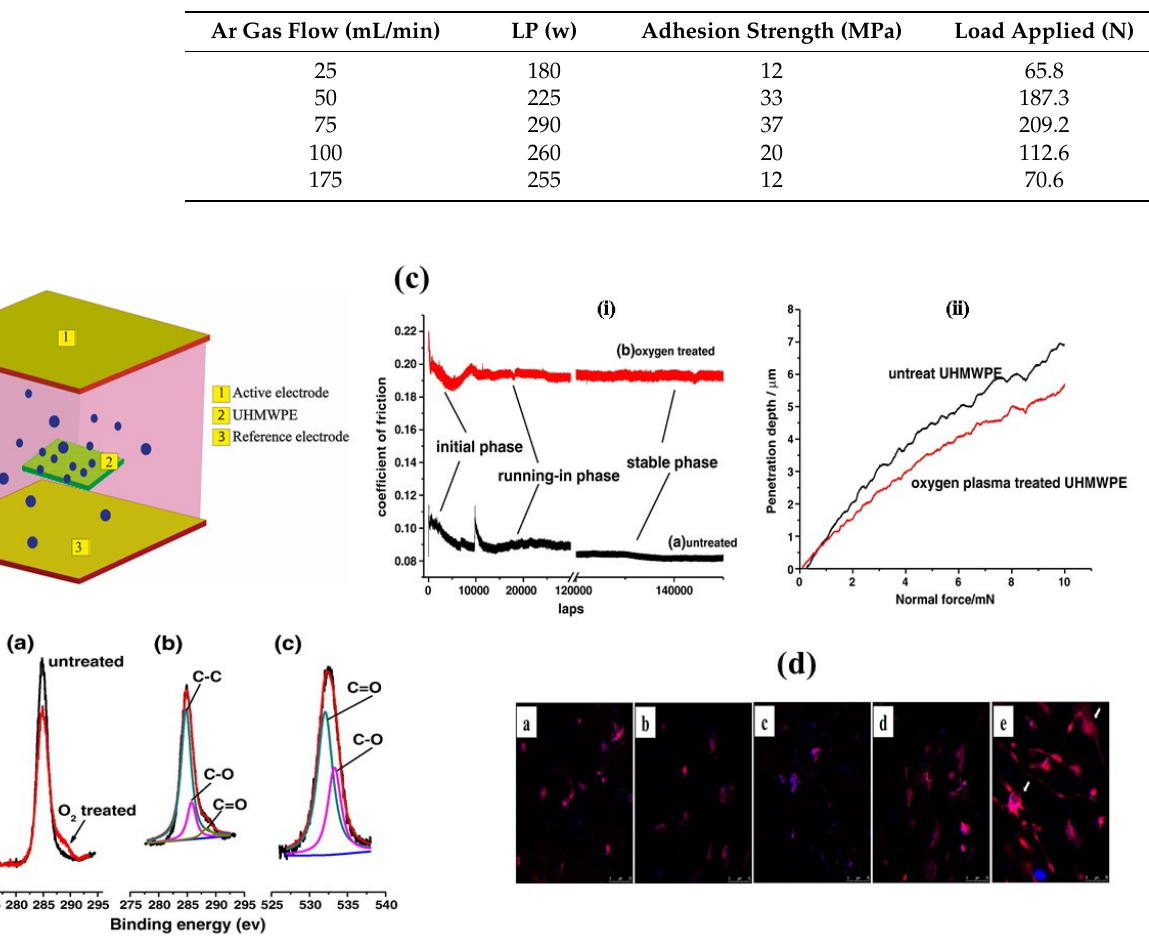
Figure 8. ( a ) Plasma-assisted chemical vapor deposition (PACVD) coating of UHMWPE fabric; ( b ) introduction of additional groups into UHMWPE before and after treatment, reprinted with permission from [34]; ( c ) (i) friction coefficient of friction of untreated and treated UHMWPE; (ii) scratch penetration vs. load graph, reprinted with permission from [34]; ( d ) differentiation of PBMNCs to osteoclast a. Untreated UHMWPE, b. HN-1 min, c. O 2 -1 min, and d. HN-2 min do not display presence of osteoclasts, whereas e. O 2 -2 min displays the presence of multinucleated giant osteoclasts on its surface (indicated with arrows). Reprinted with permission from [33].